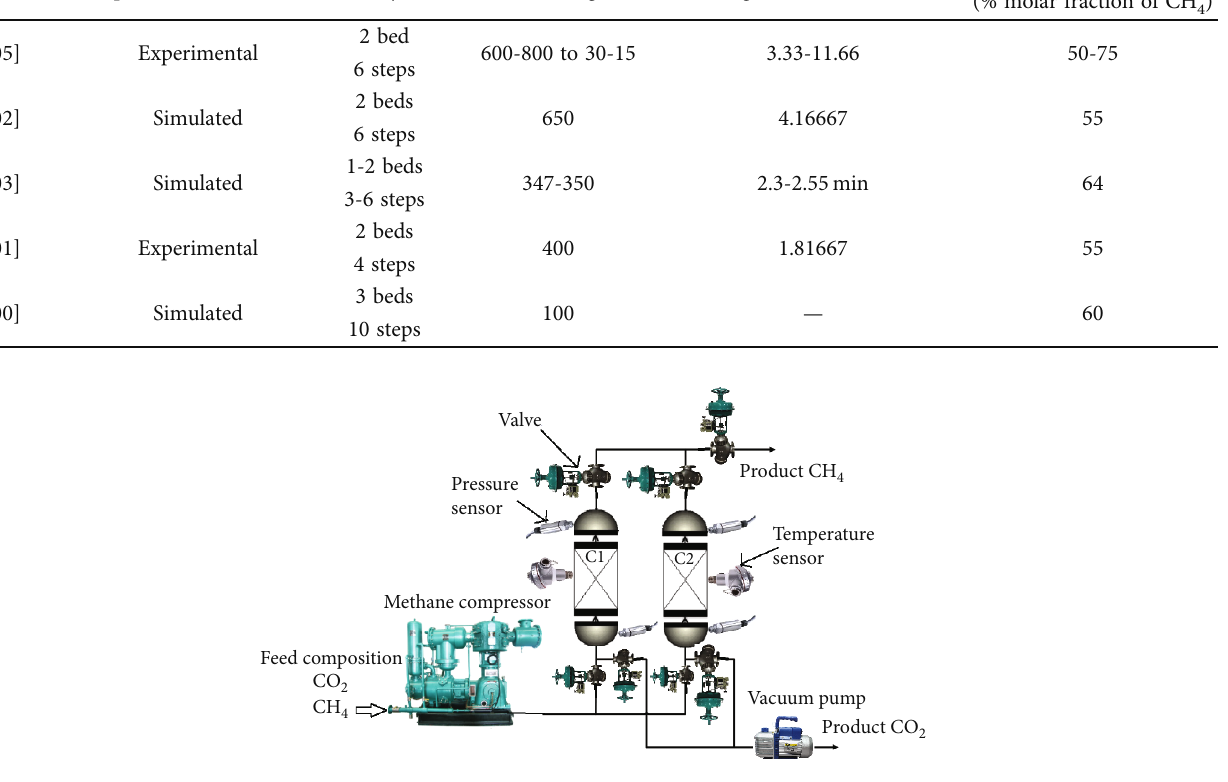
Figure 12: Schematic diagram of the PSA process using 2-beds, 6-steps. Table 22: Distributed parameter models of the PSA processes for biomethane